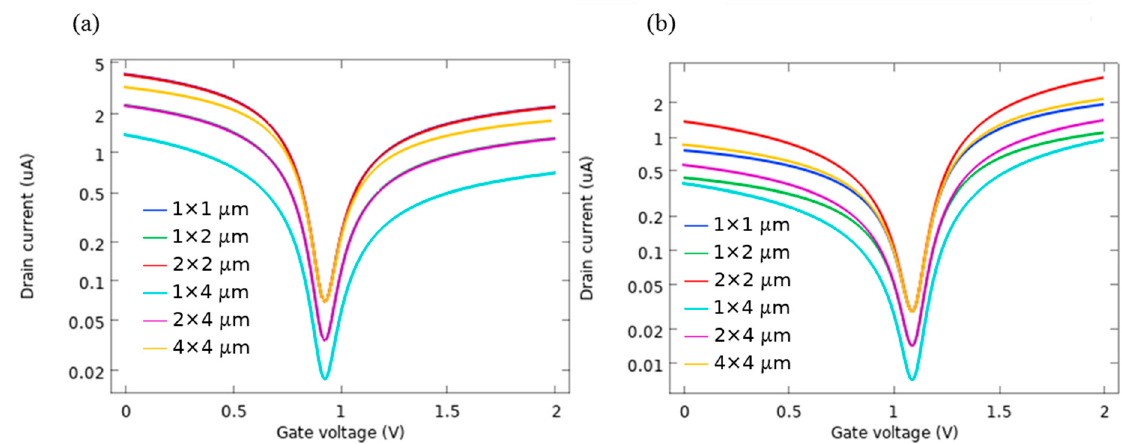
Figure 10. I–V characteristics as a function of channel dimension (W × L), for ( a ) AlP-GFET ( b ) Pd-GFET. The I d of the devices with equal W ratios are overlapped. L